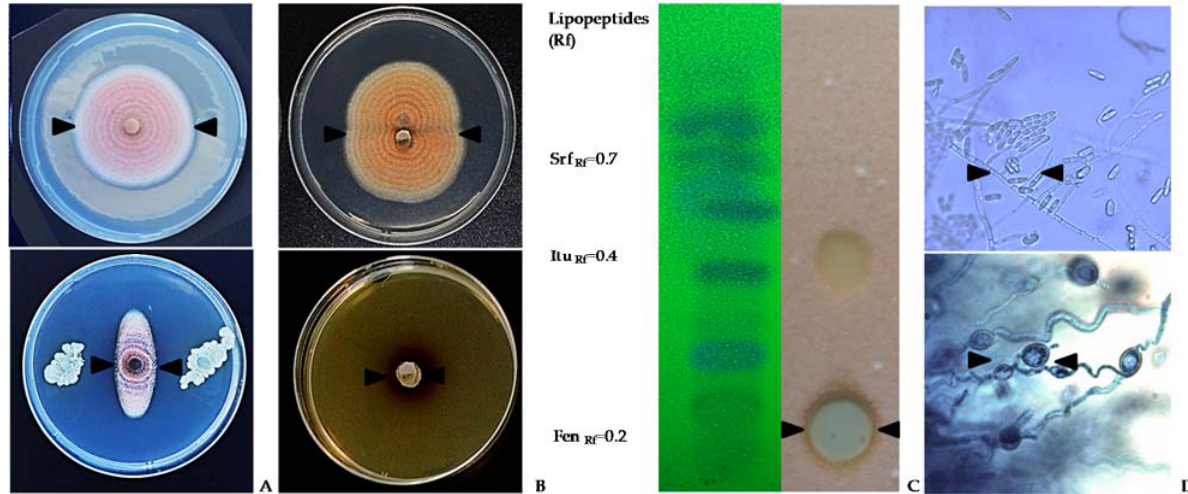
Figure 4. Antifungal activity of Bacillus subtilis against C. lupini . Black arrows show pathogen mycelial inhibition by bacterial biomass ( A ), cells free supernatant ( B ), and lipopeptides extract ( C ) compared with untreated control. Microscopic images of pathogen from growth zones ( D ) showing deformation and death of mycelia from bacterial treatments compared with untreated control. Source: [57–59]. Several studies found that the broad antimicrobial effect of Bacillus spp.